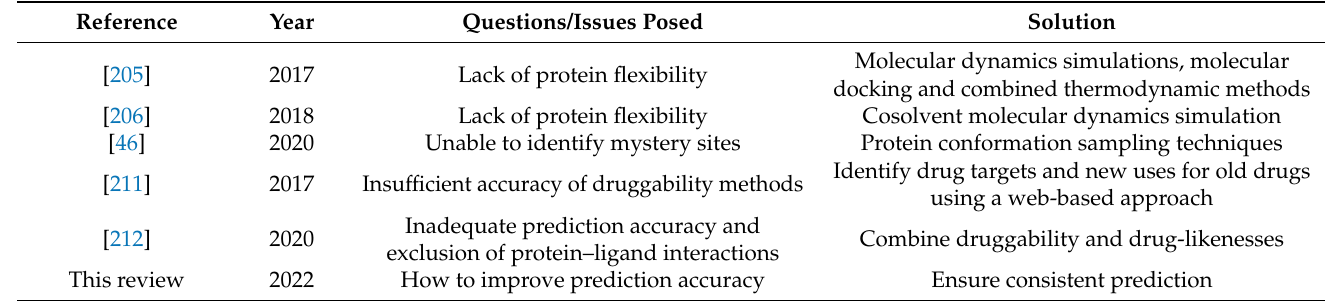
Table 9. Comparison of Previous